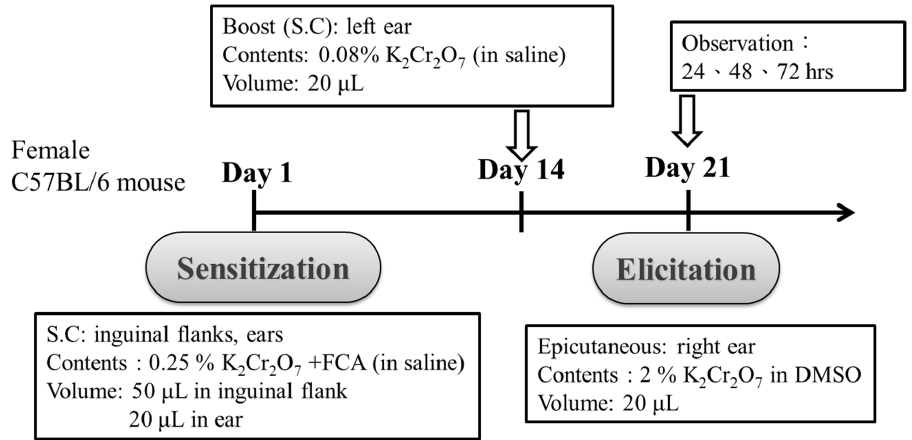
Figure 1. Scheme of intradermal sensitization and epicutaneous elicitation in an allergic contact dermatitis mouse model. S.C.: subcutaneous injection. J. Clin. Med. 2018 , 7 , x FOR PEER REVIEW